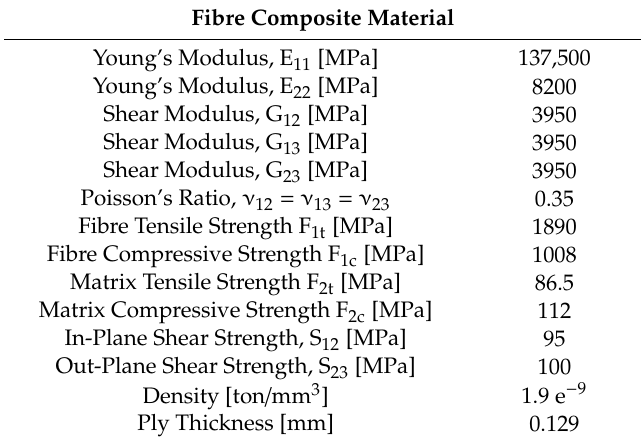
Table 2. UNIDIRECTIONAL (UD) material system properties.